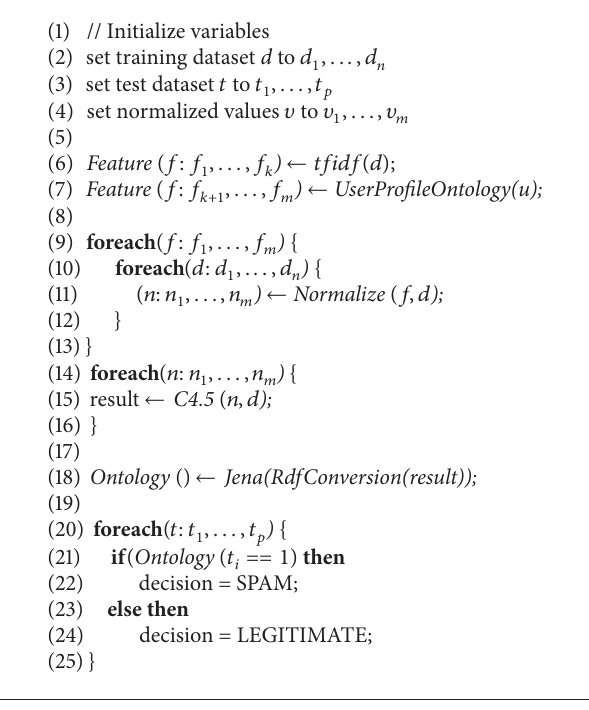
Algorithm 2: User-customized ontology filter pseudocode.